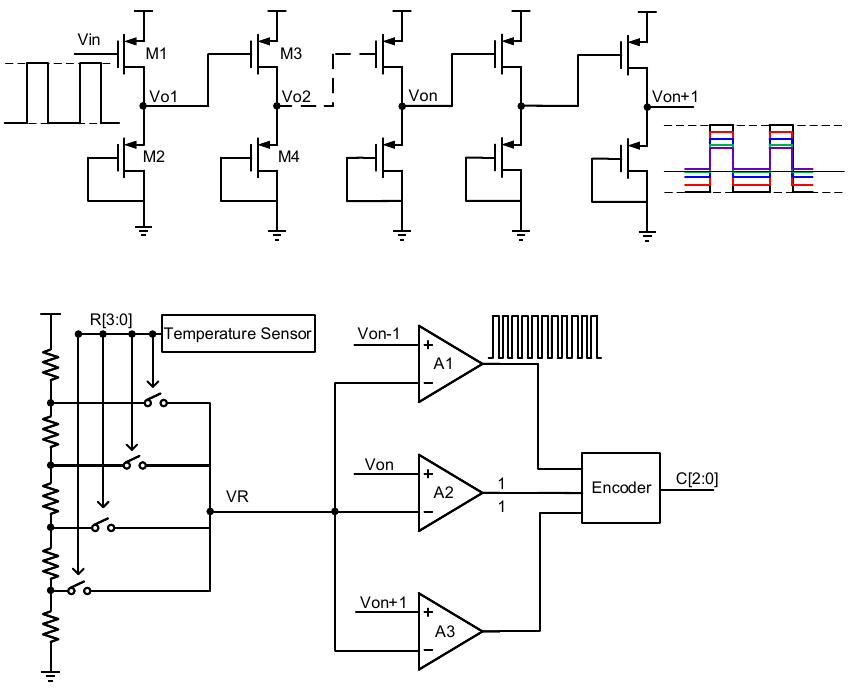
Figure 4. Process corner detection